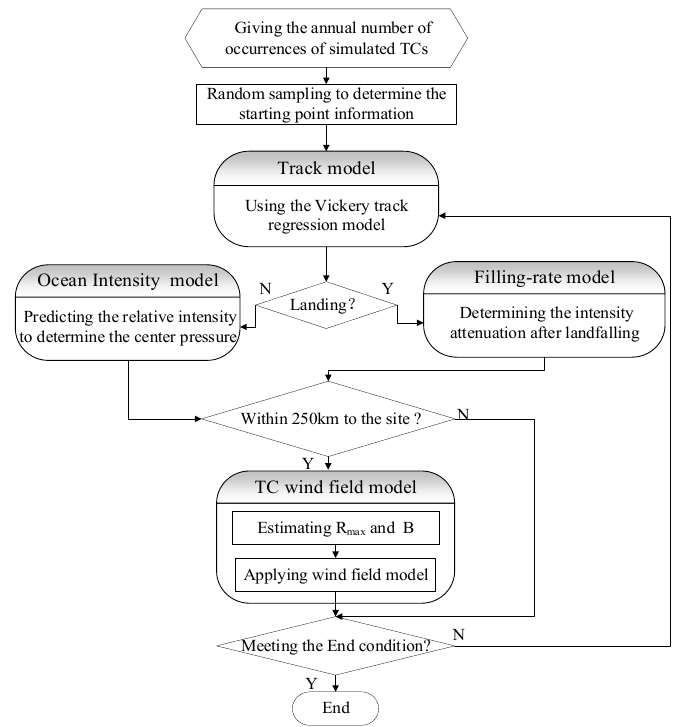
Figure 14. Flow chart of full-track simulation of single typhoon.